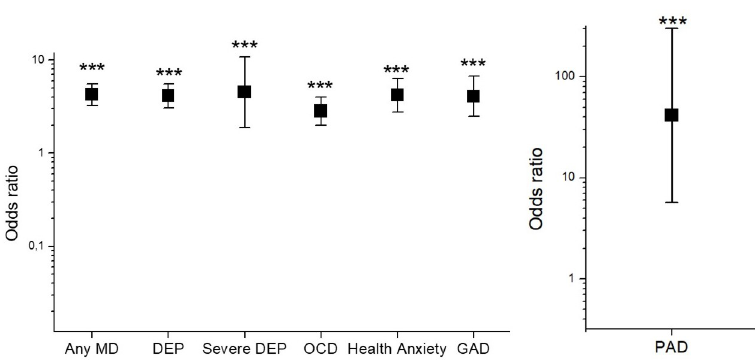
Fig 1. Odds ratios (log-scaled) of different mental disorders in association with resilience during Covid-19 pandemic in Germany. Any MD = Any mental disorder, HA = Health anxiety, PAD = Panic Disorder, GAD = General Anxiety Disorder, OCD = Obsessive Compulsive Disorder, DEP = Depression, Sev DEP = severe Depression. �� p < .01, ��� p < .001.